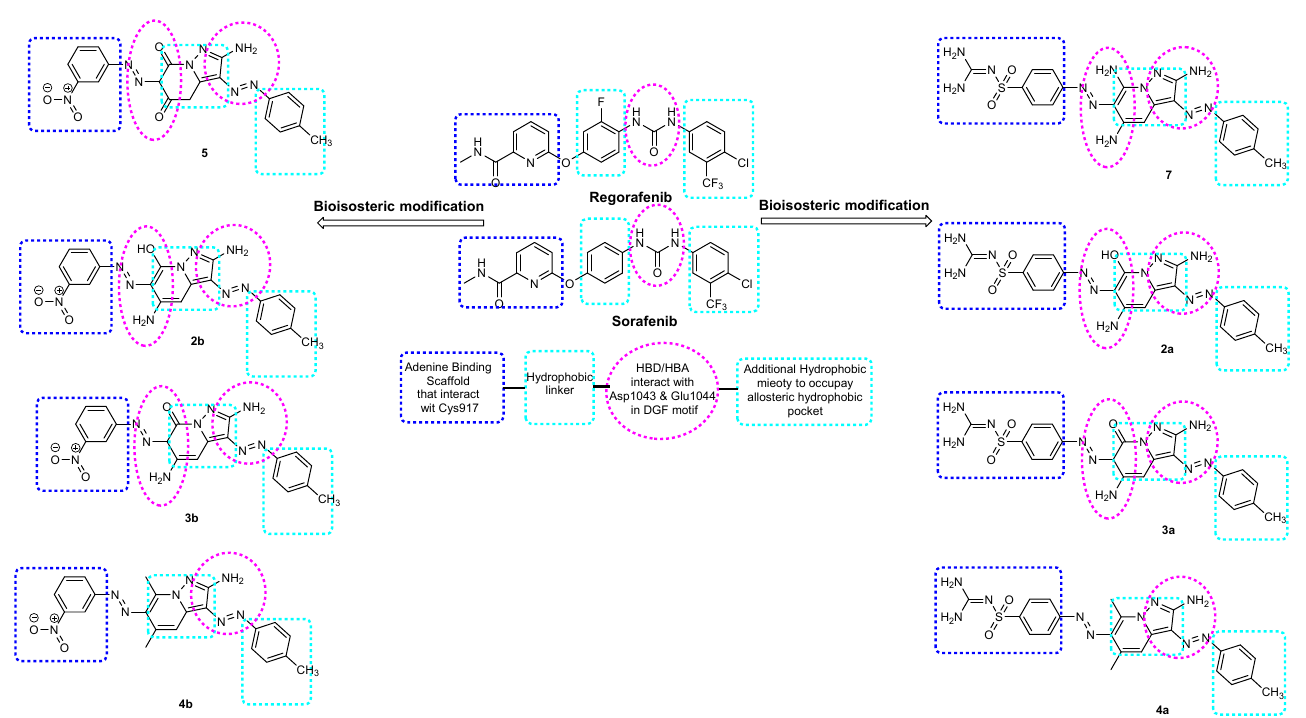
Figure 1. The essential pharmacophore features for sorafenib and regorafenib as reported VEGFR-2 inhibitors, and structure similarity between these potent VEGFR-2 inhibitors and the designed pyrazolopyrimidine derivatives containing sulphonyl-guanidine moiety ( 2a , 3a , 4a , 7 ) and nitro group ( 2b , 3b , 4b , 5 ). Cyan and blue squares represent hydrophobic features (HYD), while purple ovals and circles represent hydrogen bond acceptors (HBA) and/or donors (HBD) moieties. The acetamido fragment of the adenine binding scaffold of sorafenib and regorafenib